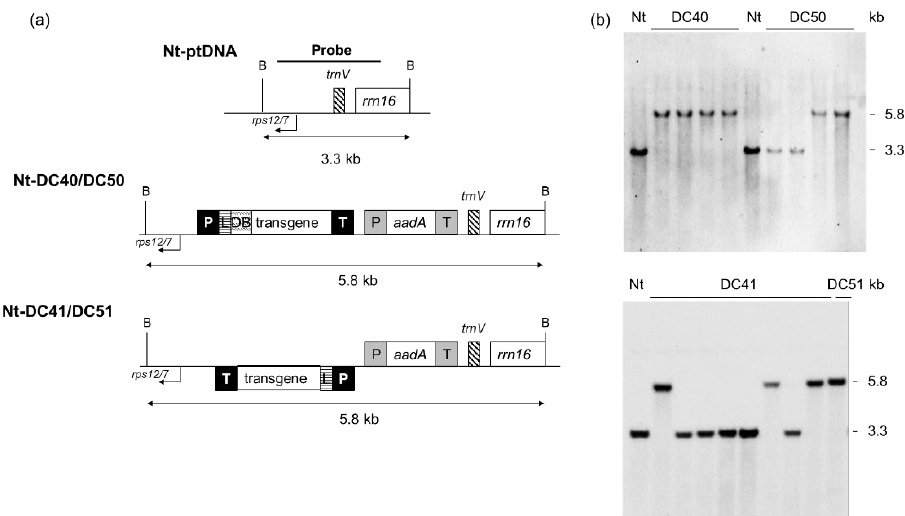
Figure 2. Identification of homoplasmic transplastomic tobacco lines for each construct. Schematic representation of the targeting region in the plastid genome (Nt-ptDNA) and maps of transformed (Nt-DC series) plastid genome regions involved in transgene integration. Below the maps are the indicated expected sizes of the Bam HI DNA fragments in Southern blot analyses. rps12/7 and trnV correspond to the plastome integration site of the expression cassettes. ( a ) Selection of homoplasmic lines by Southern blot analyses. Examples of transplastomic lines obtained with each vector are reported. ( b ) TrAA9B, AA9 LPMO from Trichoderma reesei ; TaAA9B, AA9 LPMO from Thermoascus